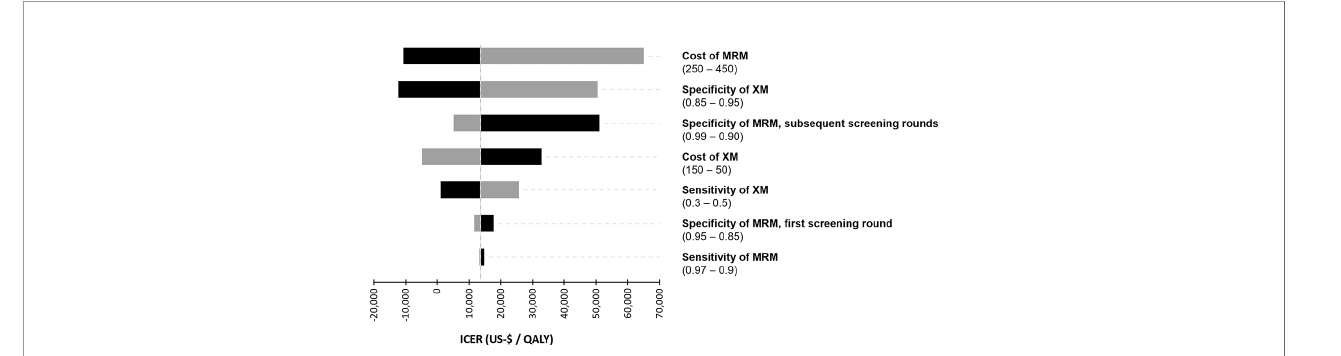
FIGURE 2 | Tornado diagram of the deterministic sensitivity analysis. Costs of the diagnostic procedures (US-$) and the diagnostic performance were varied within a reasonable range to illustrate their impact on the incremental cost-effectiveness ratio (ICER).